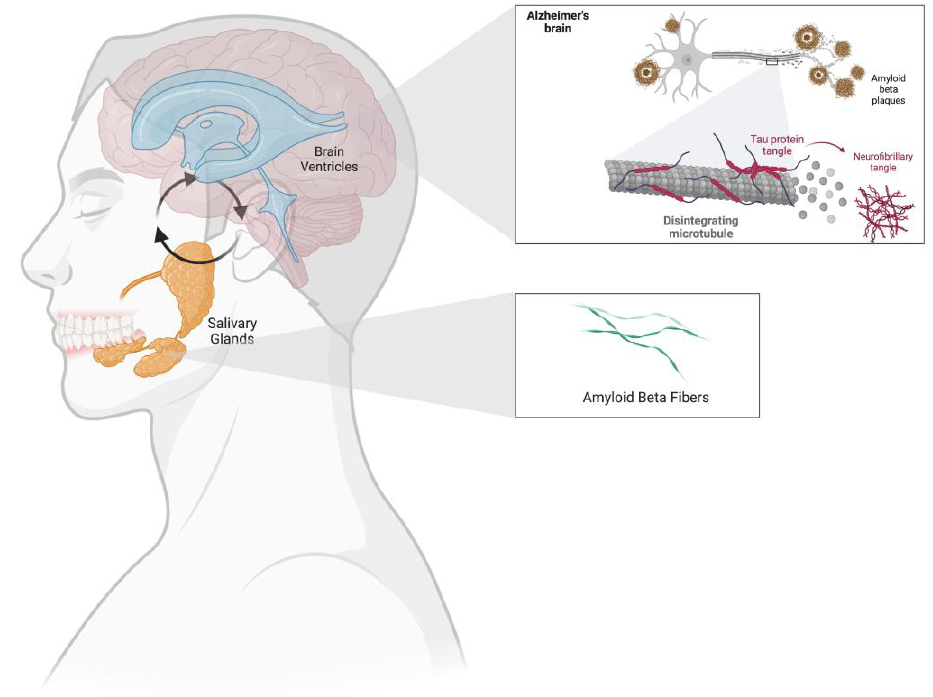
Figure 1. The hypothetical interaction linking the pathological processes of Alzheimer’s disease at the brain level and pathological amyloid- β fragments at the salivary level. This figure was made with Biorender.com.